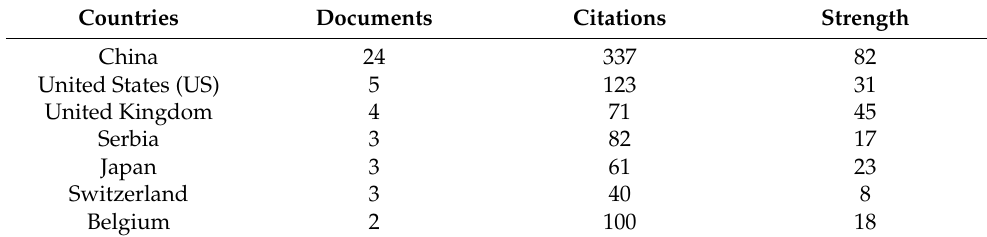
Table 2. Originating countries of the reviewed authors’ institutions.